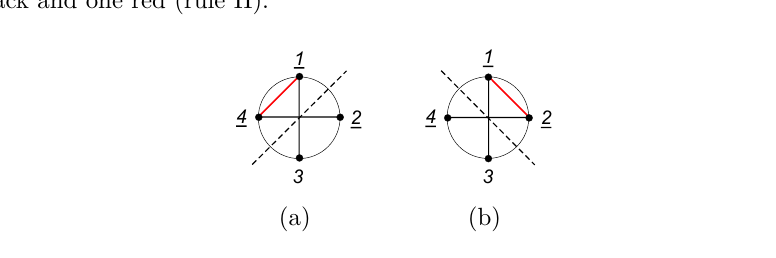
Figure 5 . Factorization of A ( I 4 ) with (a) Pf A 14